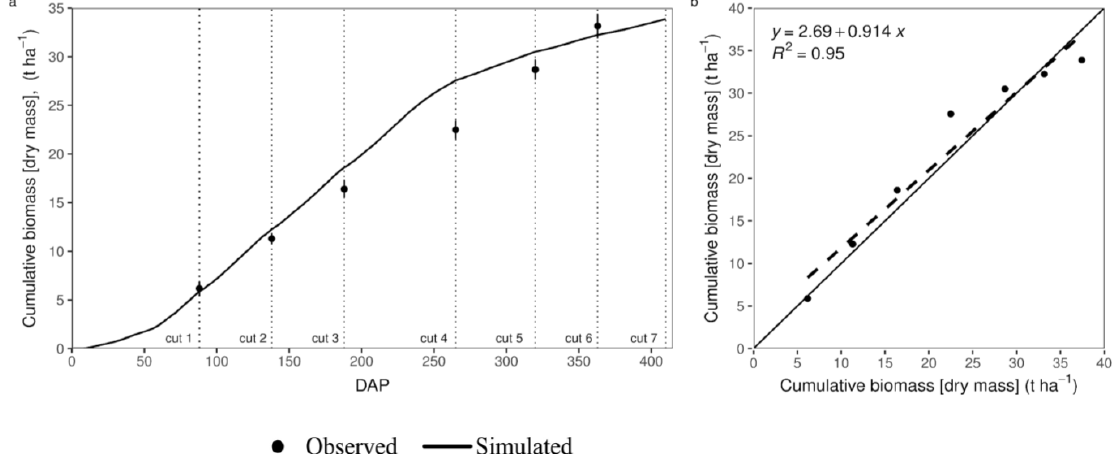
Figure 4. Simulated and observed values of cumulative biomass ryegrass ( Lolium perenne L.) during model calibration (C1-Irrigation: full irrigation treatment in the first cropping season of ryegrass). ( a ) Measured and simulated cumulative biomass during the growing season; ( b ) regression of measured and simulated cumulative biomass. Diagonal lines represent 1:1